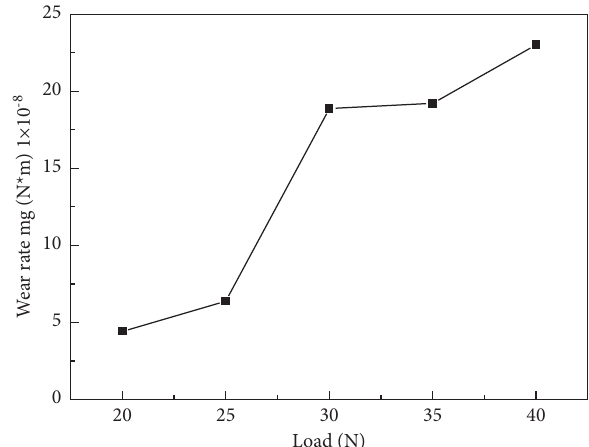
Figure 11: The relationship between the load and the wear